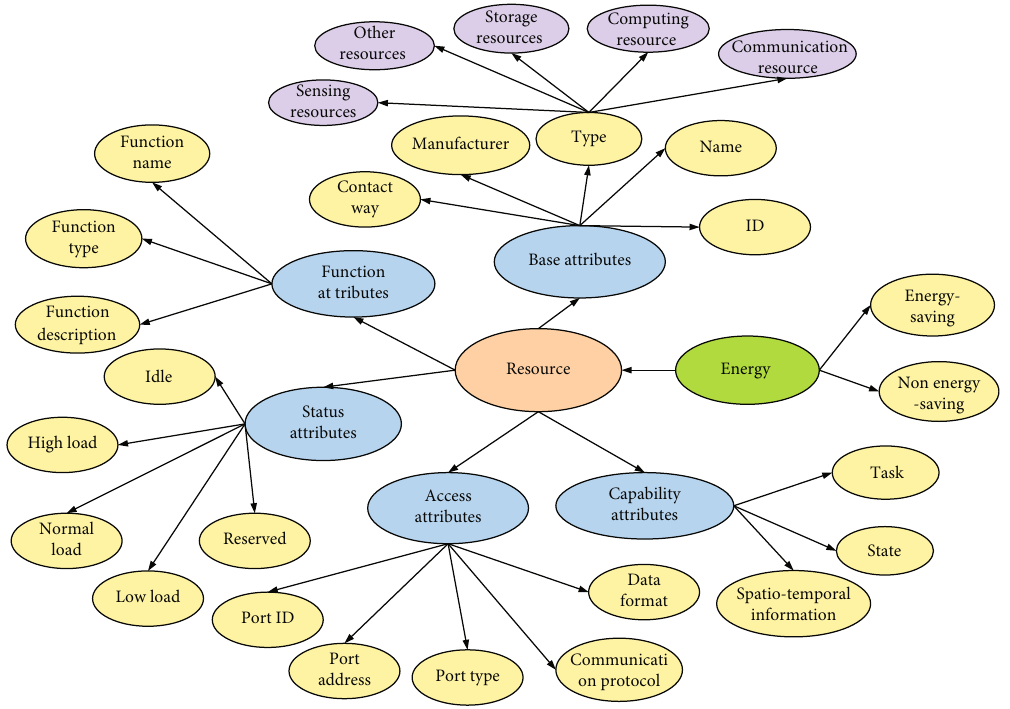
Figure 2: Conceptual model of resource ontology when regarding energy